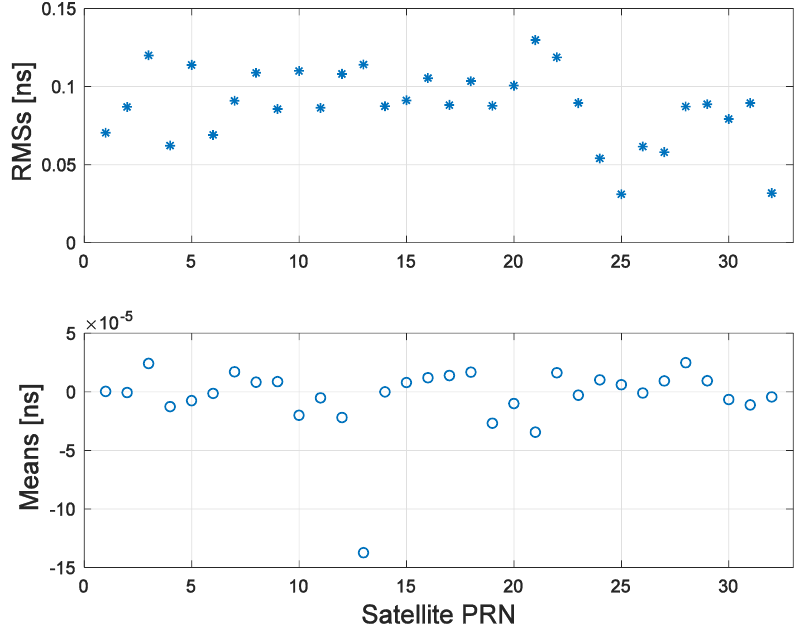
Figure 3. The means ( bottom ) and RMSs ( top ) of the second-order, time-difference GPS clock errors, with one-day final 30-s IGS clock products as the “true” value, with 30-s sampling intervals.